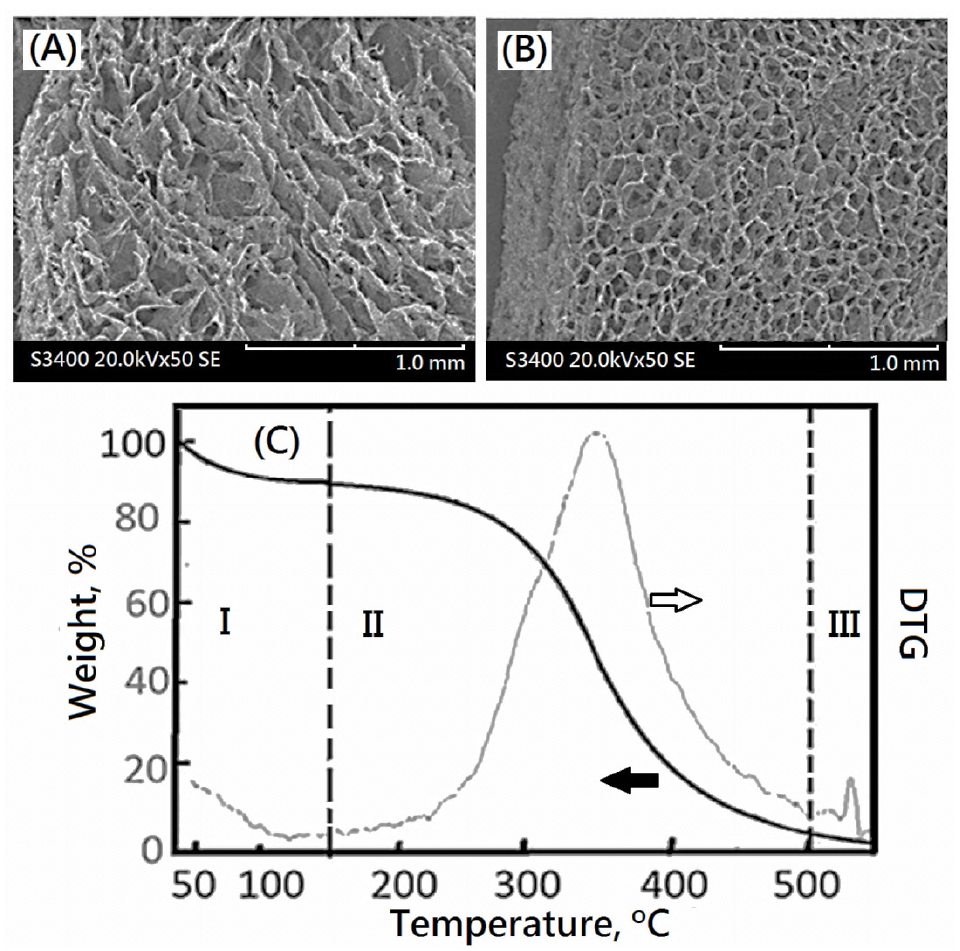
Figure 10. The SEM images of ( A ) collagen nano-bioscaffold and ( B ) designed composite nano-bioscaffold, and ( C ) the weight percent and DTG profiles of designed composite nano-bioscaffold. The TGA provided information about the behavior with the temperature presented by the resulting composite nano-bioscaffold of cross-linked collagen and decellularized bio-scaffolds containing acellular matrix as shown in Figure 10C. The main loss is pre- sented in three different temperature ranges given by temperature region I: (<150 ◦ C); Figure 10C. The decrease trend of the weight loss curve in region I would be resulted from the loss of the physisorbed water in the resulting composite nano-bioscaffold, which represented the 10 wt% of the collagen complex bioscaffold, which occurred at 40 ◦ C.